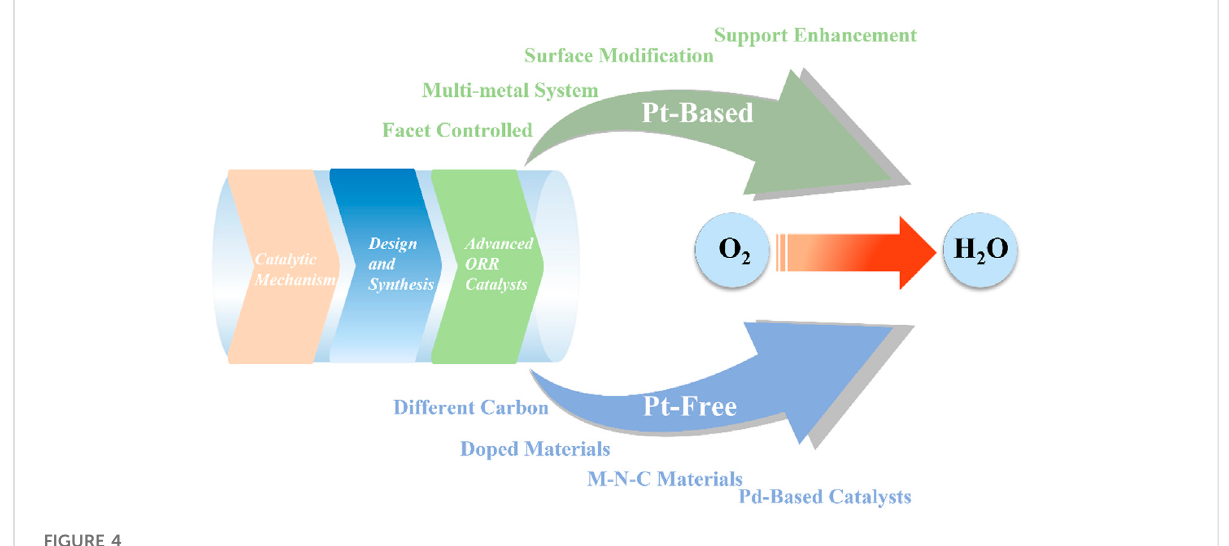
FIGURE 4 Low Pt-based catalysts and Pt-free catalysts for